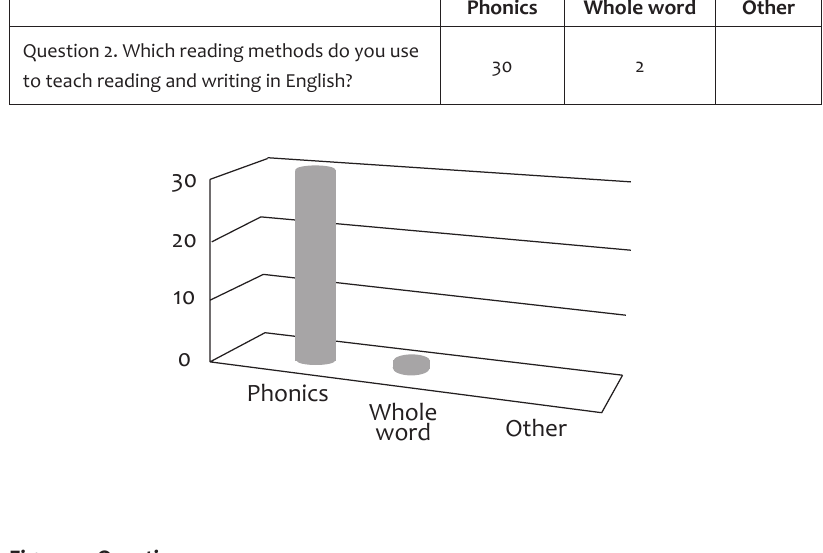
Phonics Whole word